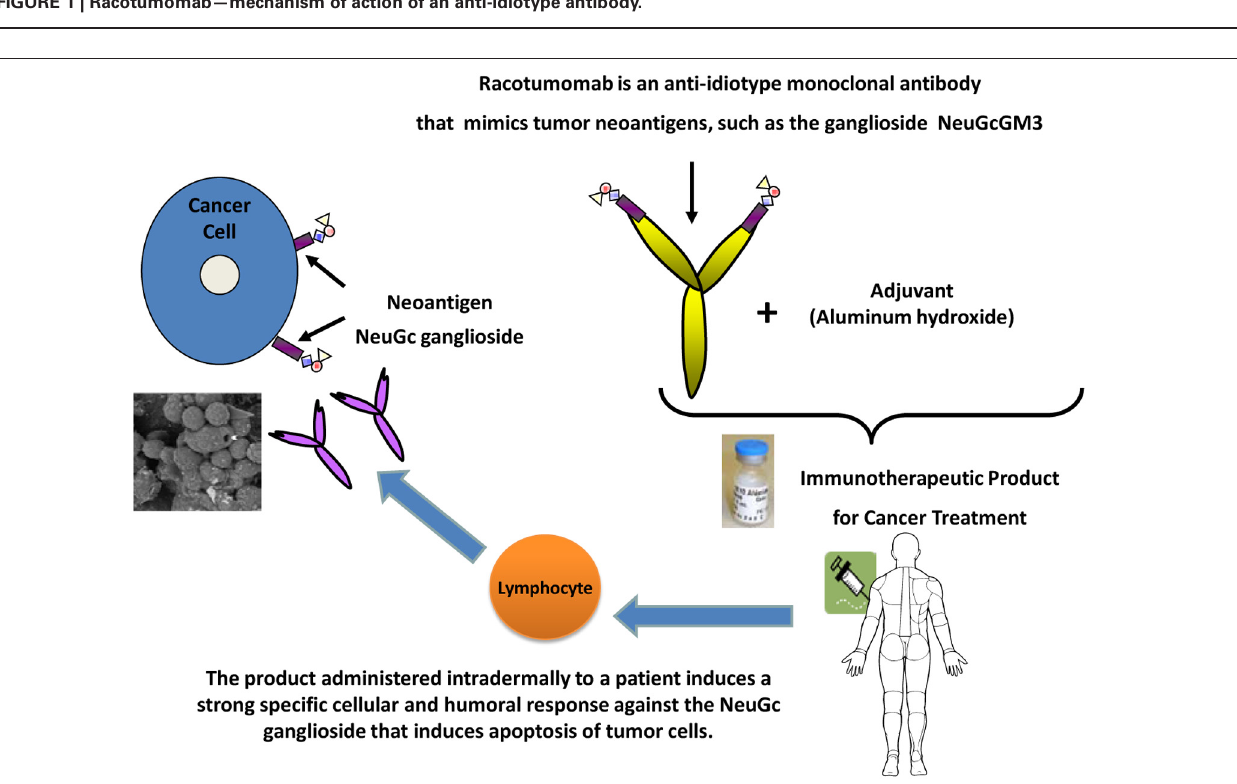
FIGURE 2 | Immune response to vaccination with Racotumomab.